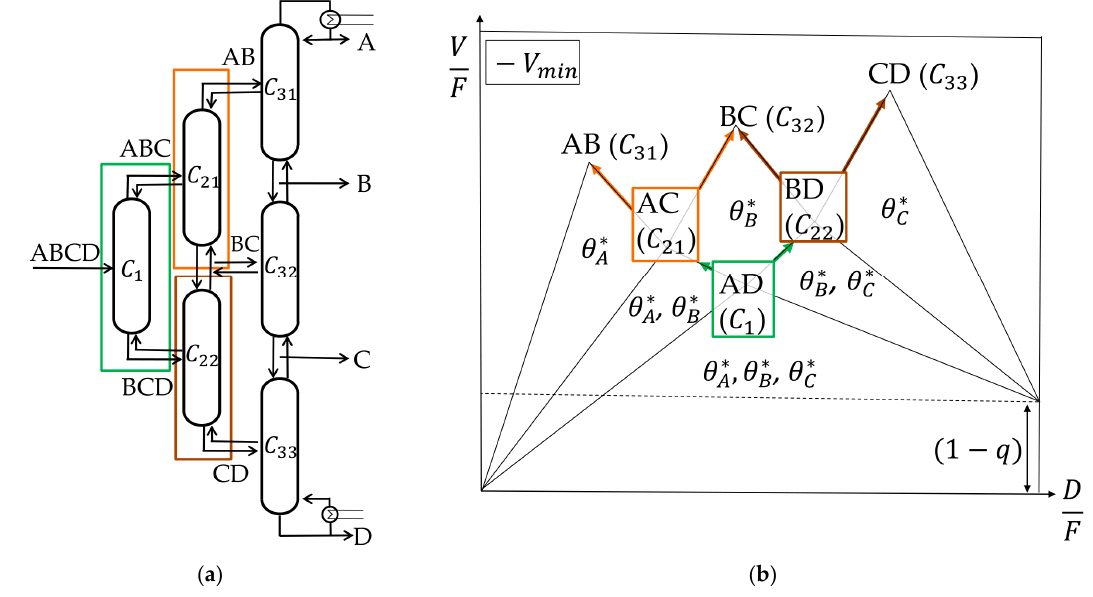
Figure 5. ( a ) Petlyuk configuration for a four component split and ( b ) corresponding V min diagram showing the carryover of common Underwood Roots (modified after